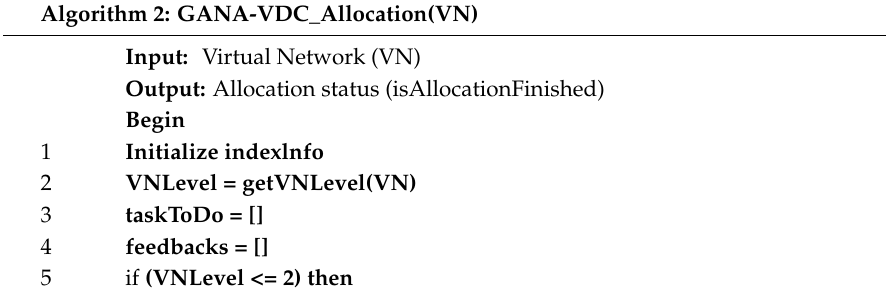
Algorithm 2: Algorithm 2: GANA-VDC_Allocation(VN)